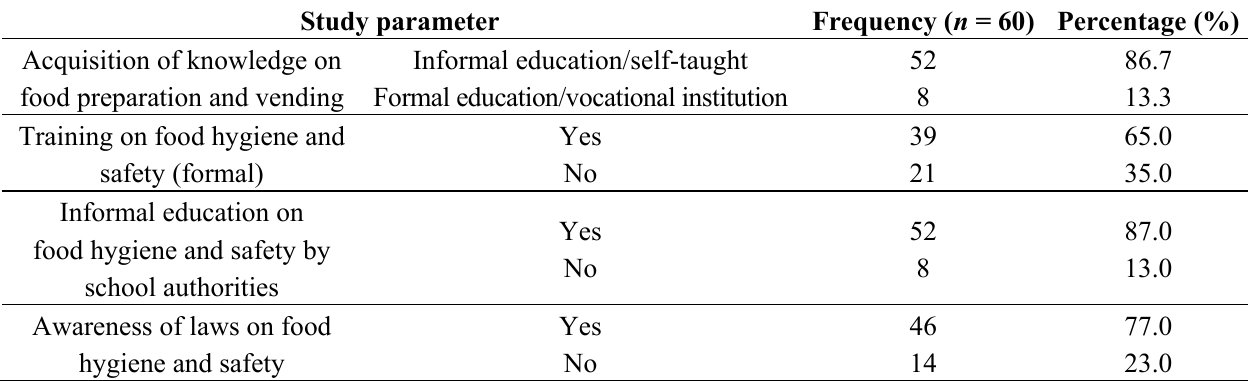
Table 2. Respondents’ level of knowledge on food